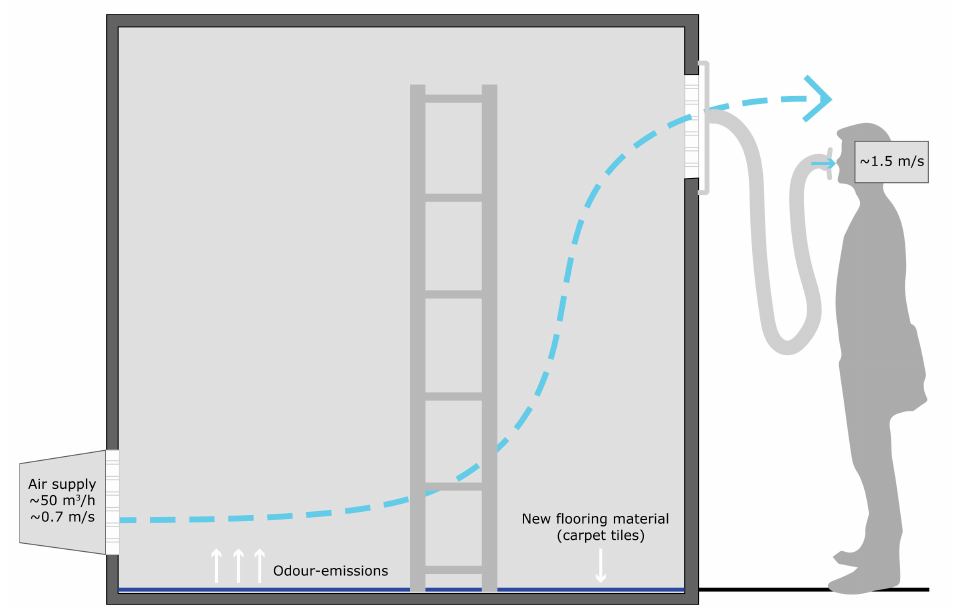
Figure 3. Setup of Chamber